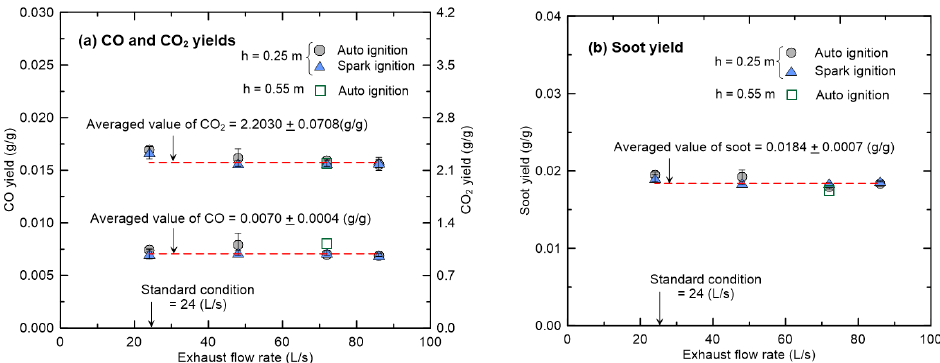
Figure 12. Variations in CO, CO 2 , and soot yields with changes in exhaust flow rate and hood height (h).